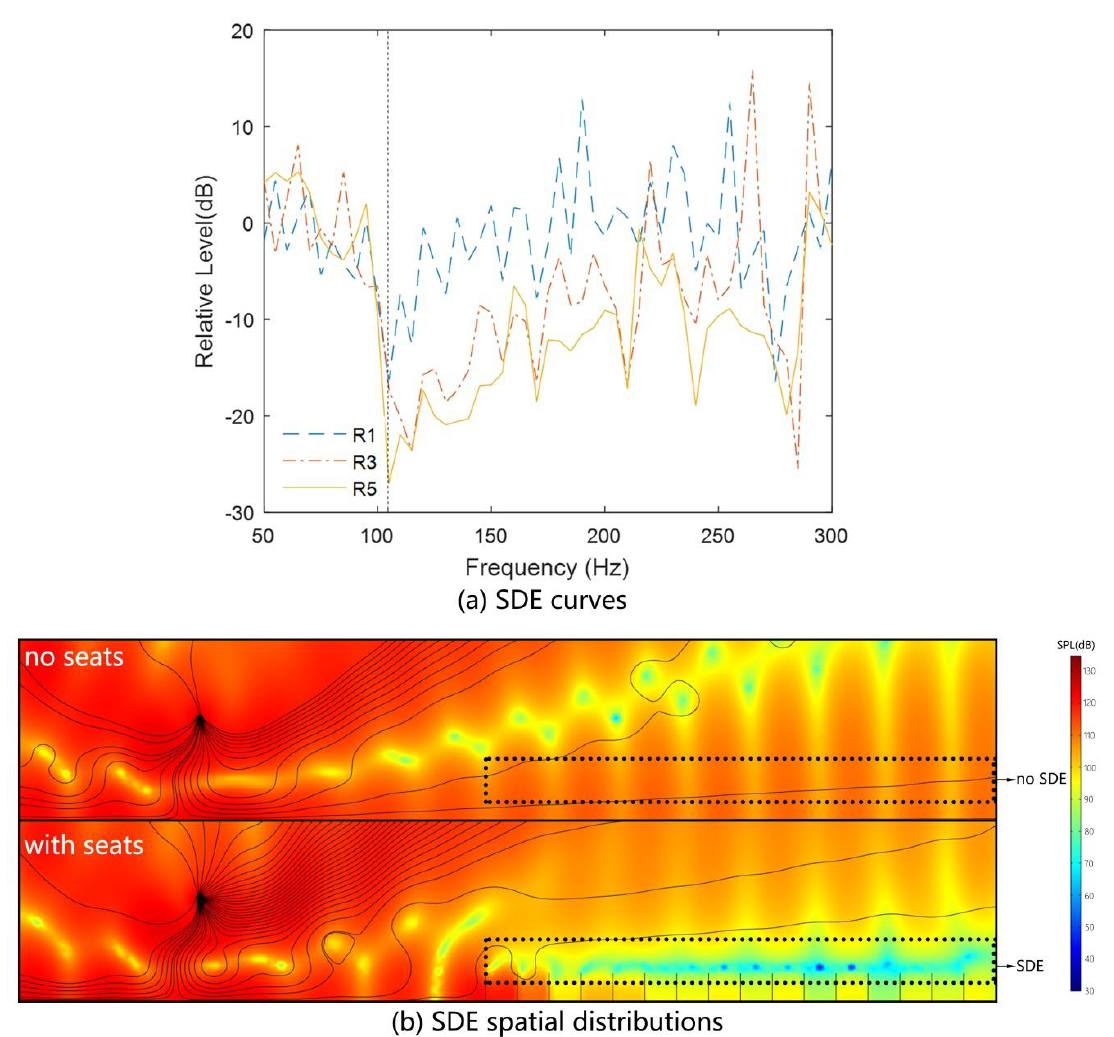
Figure 3. Illustration of the SDE: ( a ) relative level spectra; ( b ) color maps of the SPL spatial distributions at a dip frequency f 0 of 105 Hz. Seats and floor are rigid.